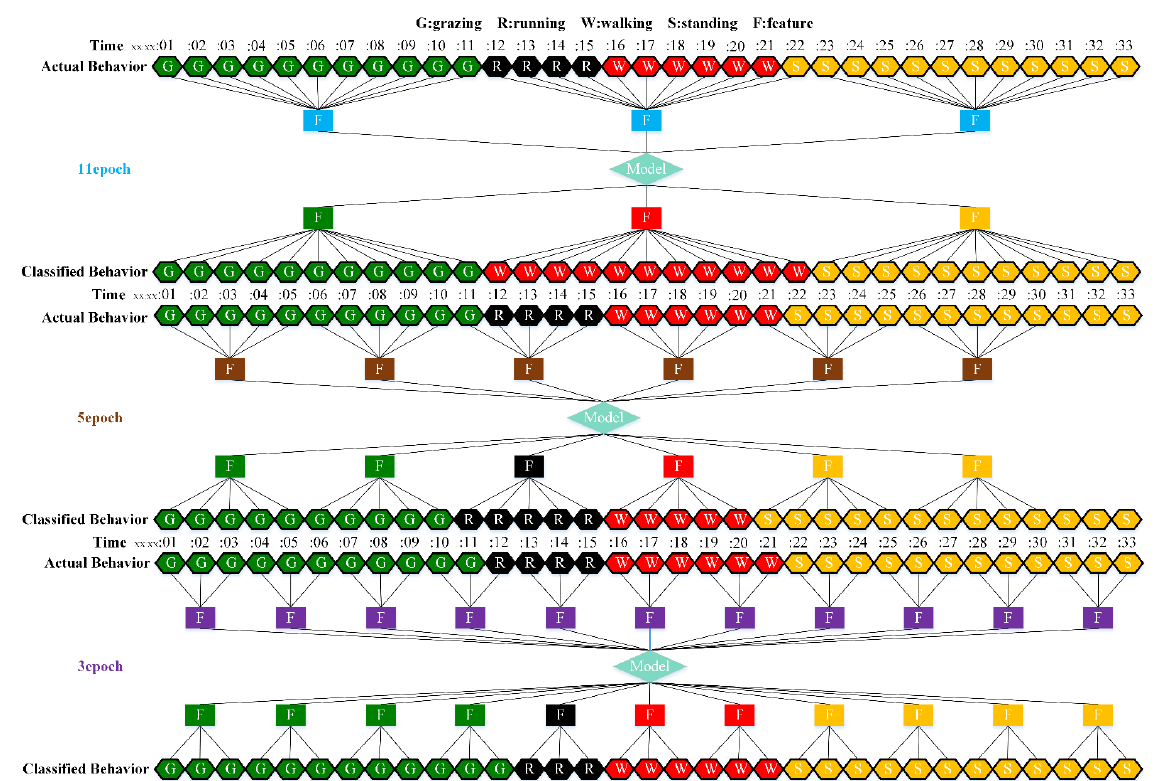
Figure 10. The process of 33 s of continuous behavior segment classification using 3, 5 and 11 s time windows with jump-moving. Assuming that the model accurately classified each behavioral feature, the classification accuracy at 3, 5 and 11 s was 97.0, 93.9 and 84.8%, respectively. Theoretically, the slide-moving window classification accuracy should be higher, so the slide-moving window was used when using the 27 trained models for continuous behavior segments classification. The final classification result at each moment was determined by the behavior with the highest prediction score among all behaviors classified by the trained model for all time windows containing that moment, as shown in Figure 11. The results of 27 trained models on the CBS test dataset are shown in Table 6. Table 6. Summary of the accuracy and Kappa values for different ML predictions of walking, standing, grazing, lying and running at 3, 5 and 11 s time windows on the CBS test dataset. Bold indicates the highest accuracy and Kappa values combination.